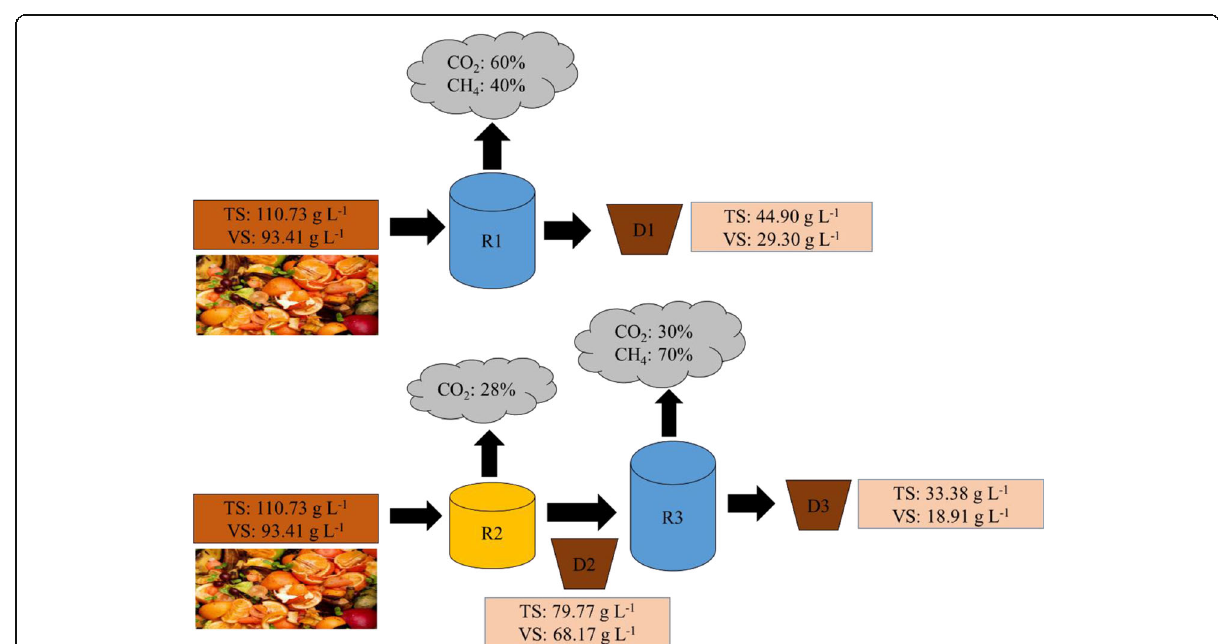
Fig. 1 Solids stream in single-stage and two-stage